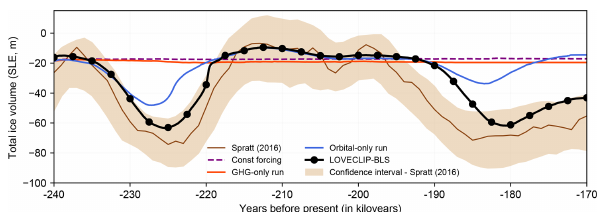
Figure 5. Effects of orbital and GHG forcings on simulated ice volumes during MIS 7. Sea level reconstruction (m) and 95% con- fidence interval of Spratt and Lisiecki (2016) (brown). Total ice vol- ume (in terms of SLE, m) from transient LOVECLIP simulations with (i) constant orbital and GHG values set at 240ka (dashed pur- ple line), (ii) orbital values set at 240ka but time-varying GHG val- ues (red), (iii) time-varying orbital values with GHG values set at 240ka (blue), and (iv) time-varying orbital and GHG values (black marked; BLS). All experiments are conducted with an α value of 2 and m of 125Wm − 2